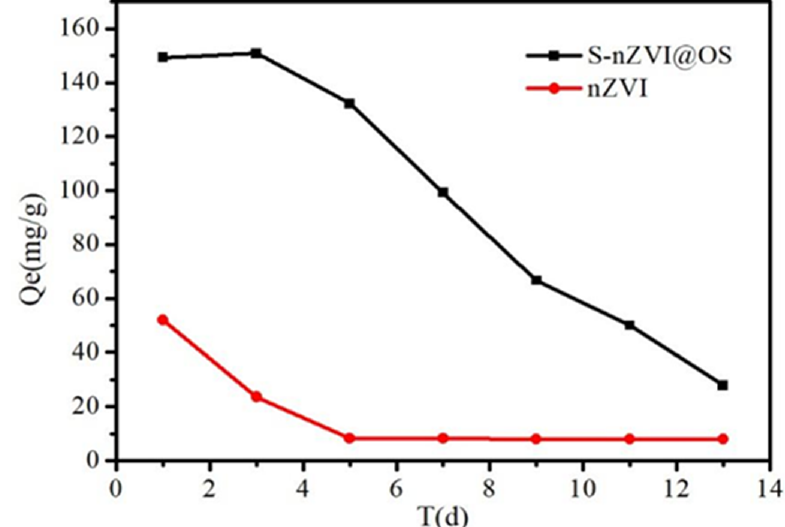
Figure 8. Changes in adsorption capacity of S-nZVI@OS and nZVI@OS over time.